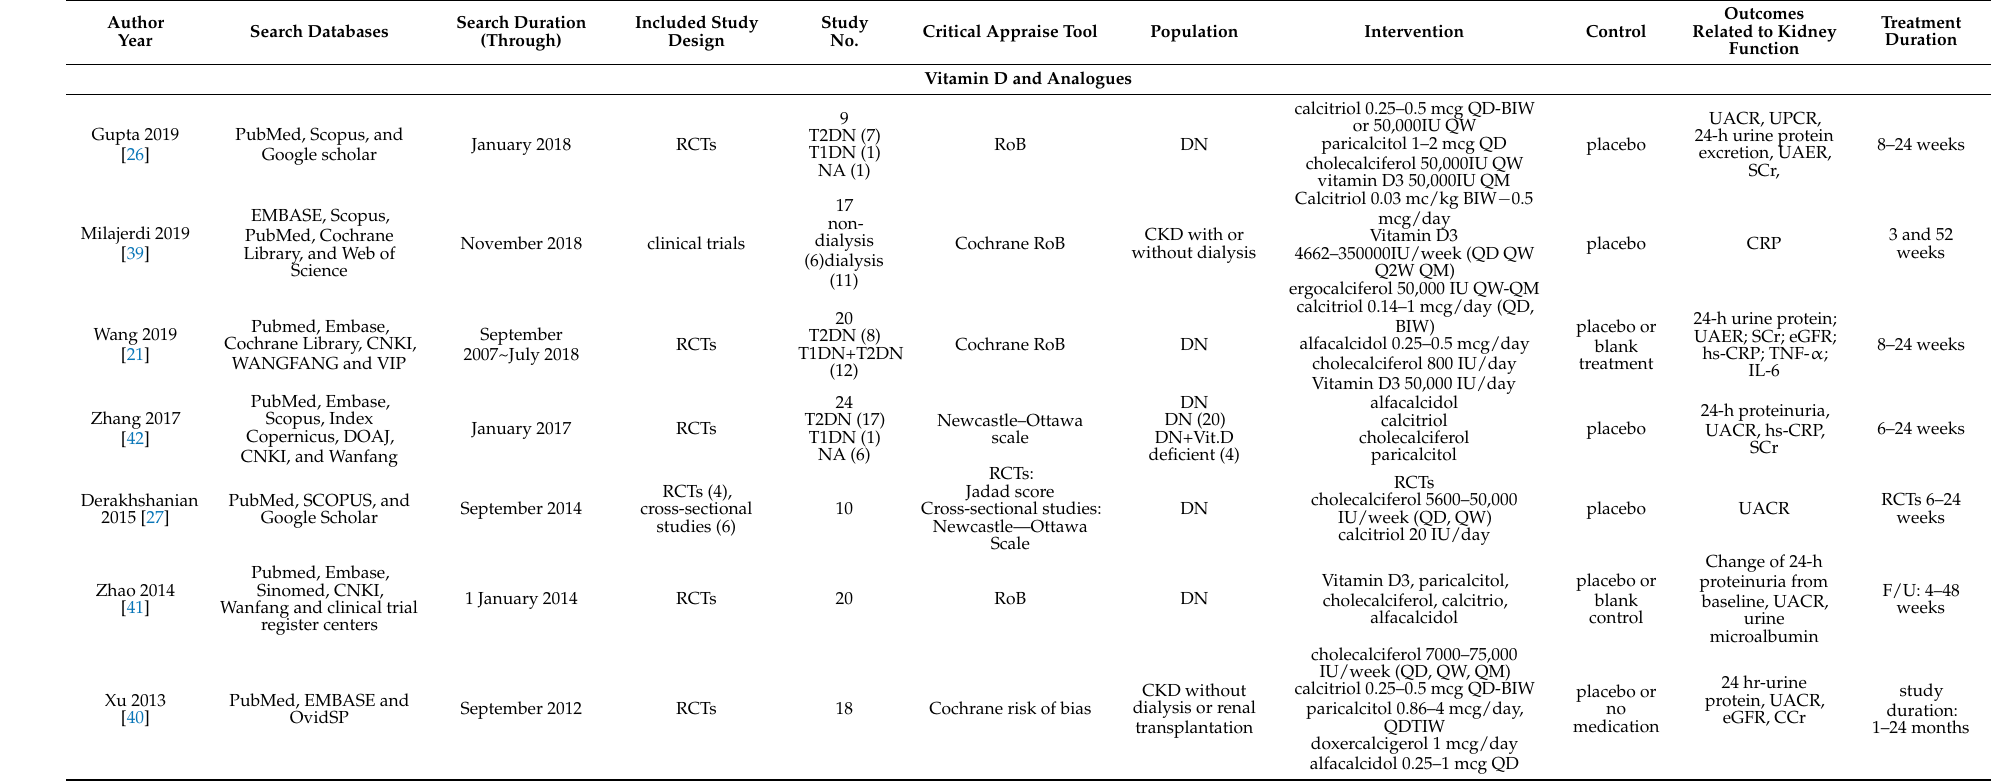
Table 1. Baseline information of included systematic